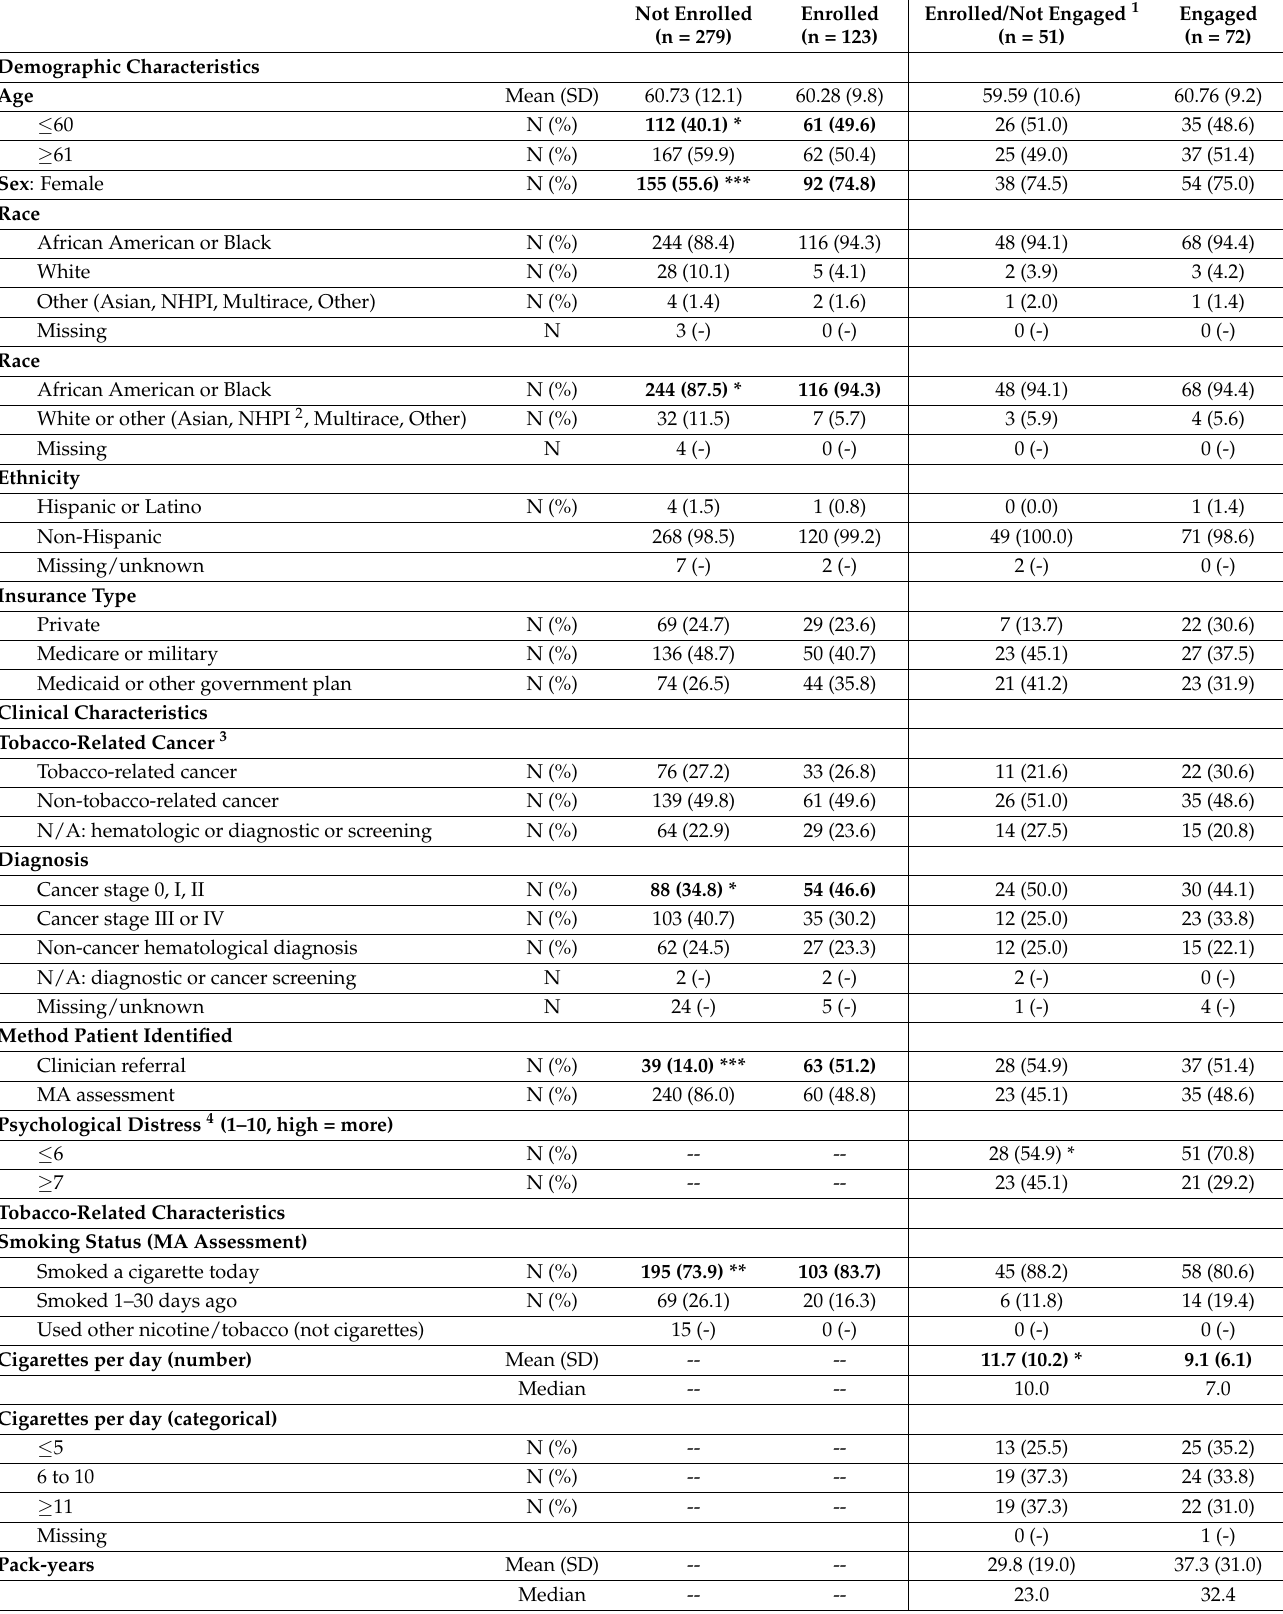
Table 5. MWHC baseline demographic, clinical, and tobacco-related characteristics stratified by enrollment and engagement (N =